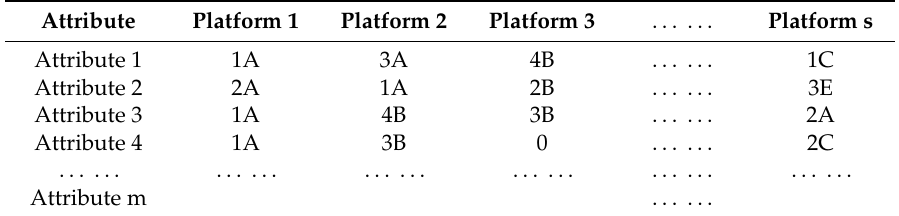
Table 2. Attribute content and accessibility.